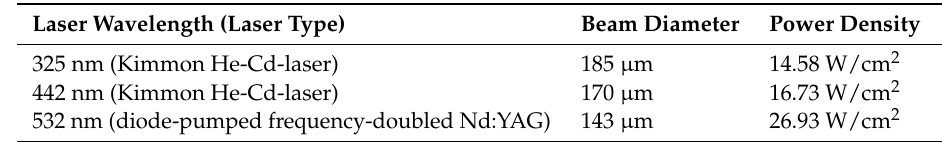
Table 3. Laser specifications. Beam diameter is given as 1/e 2 of a gaussian fit. The power density is calculated assuming a constant power distribution over the given beam